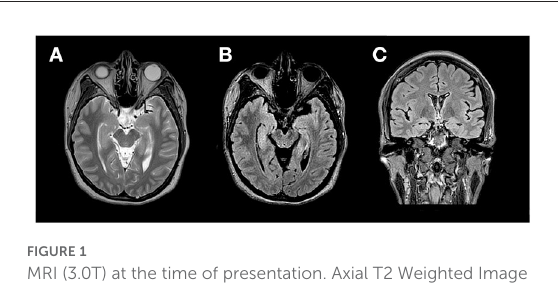
FIGURE1 MRI (3.0T) at the time of presentation. Axial T2 Weighted Image (A) , Axial Fluid attenuated inversion recovery (FLAIR) sequence (B) and coronal FLAIR (C) show cortical thickening and hyper intense signal in the medial aspect of bilateral temporal lobes Right >